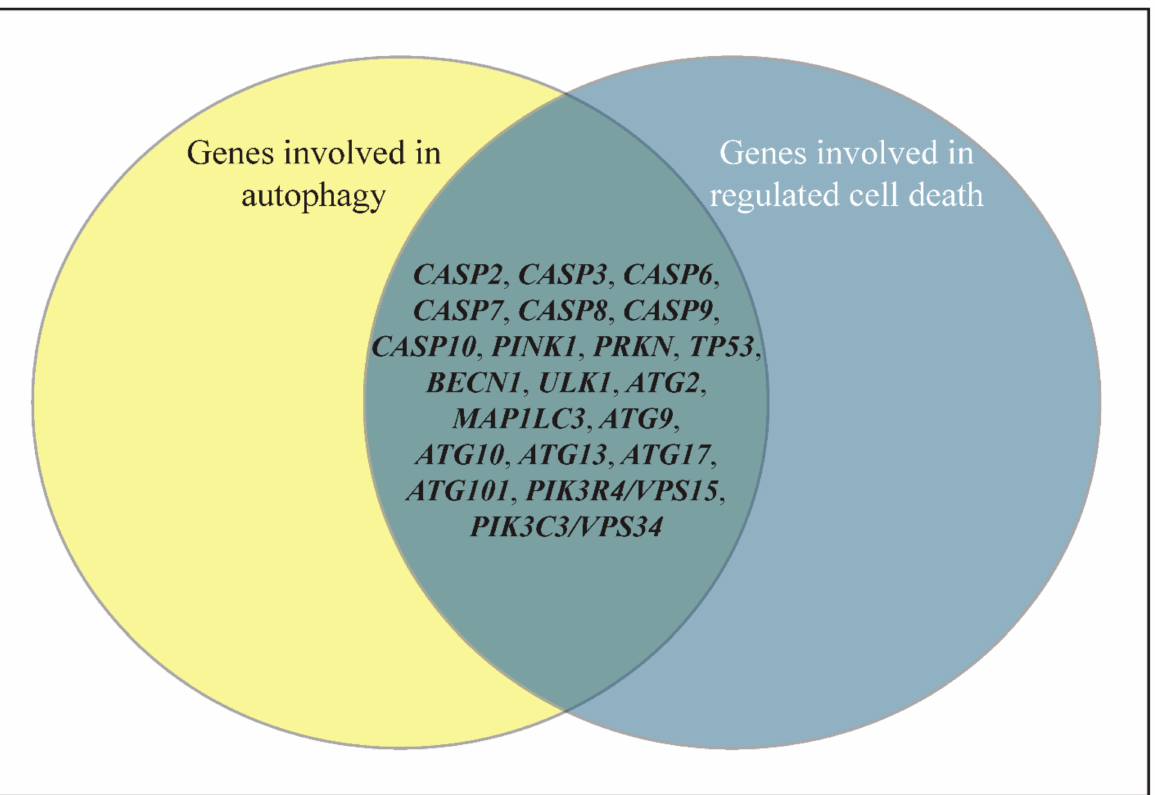
Figure 2. A Venn diagram of some genes that are shared between the autophagy and regulated cell death (RCD) pathways based on the published literature. Although the names of the genes usually reflect the pathways they were originally identified within (autophagy or regulated cell death), it is the functions of the genes/proteins that determine how and to what extent a gene can be utilized by the cells. The details of the role of these genes in autophagy and RCD can be found in the text and the references in this review